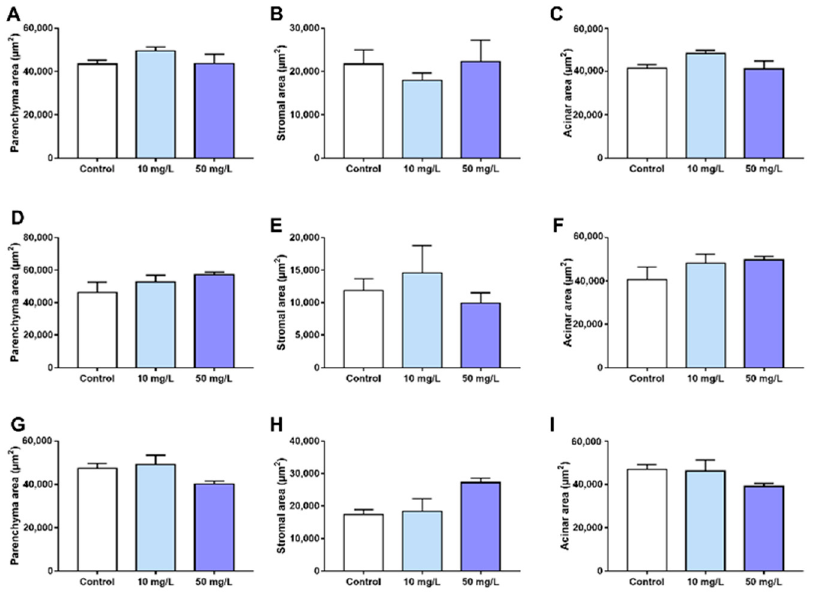
Figure 3. Effects of 60-day exposure to 0, 10, or 50 mg F/L from the drinking water on the morphometric parameters of the mice salivary glands. Graphs represent the morphometric analyses of the parotid glands (parenchyma, stromal, and acini areas represented by ( A – C ), respectively), submandibular glands (parenchyma, stromal, and acini areas represented by ( D – F ), respectively), and sublingual glands (parenchyma, stromal, and acini areas represented by ( G – I ), respectively). The results are expressed as mean ± standard error of mean. Different superscript letters indicate statistical differences among the groups. The absence of letters indicates that there was no statistical difference. One-way ANOVA and Tukey’s post hoc test. ( p < 0.05, n = 8